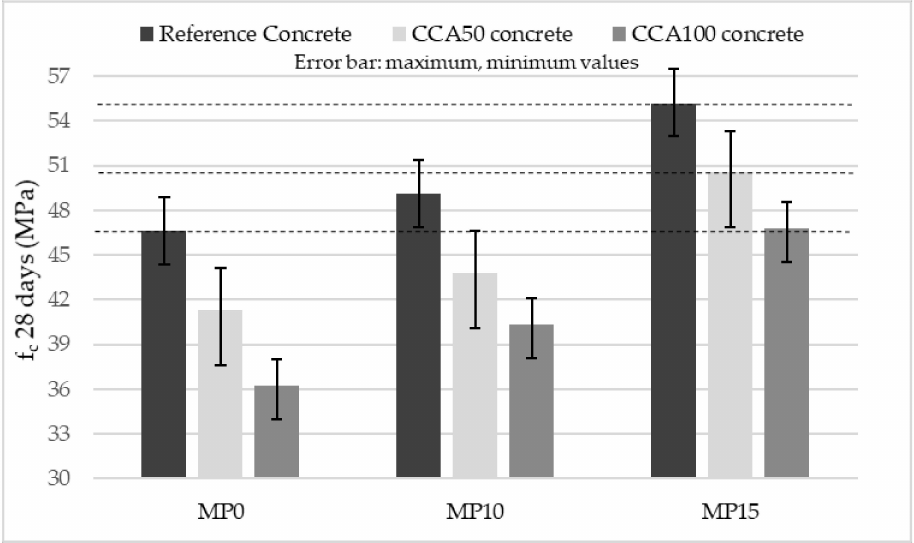
Figure 6. Mean compressive strength of concrete with mechanically pre-processed